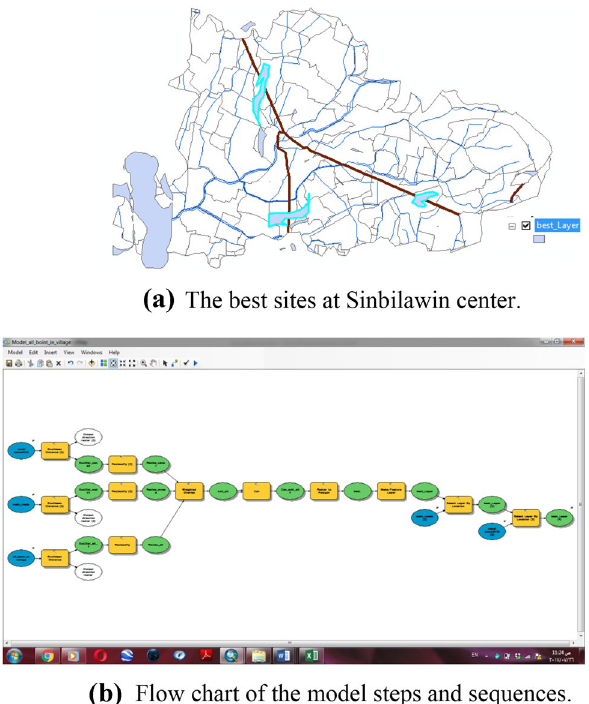
Figure 10. ( a ) The best sites at Sinbilawin center. ( b ) Flow chart of the model steps and sequences.